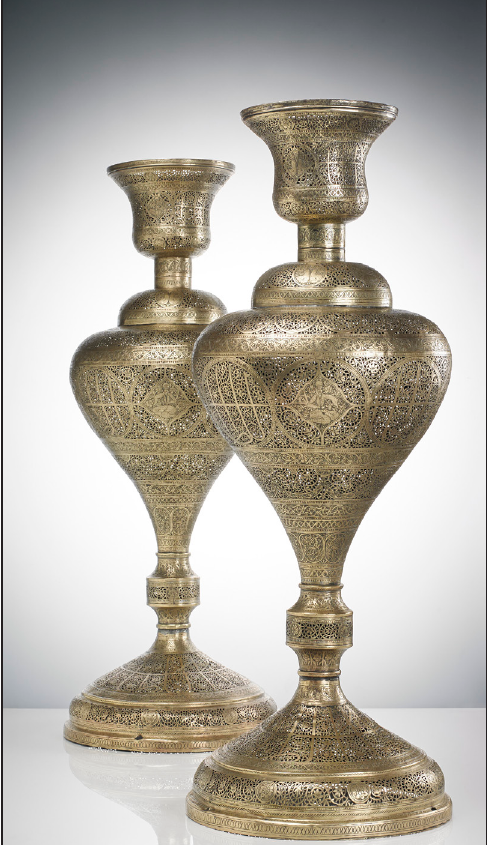
Fig. 14 : Vases, pierced and chased brass, Iran (probably Isfahan), nineteenth century. F66A and F66B, given by Miss E. G. Tanner in 1926. © Holburne Museum, Bath. Photo: